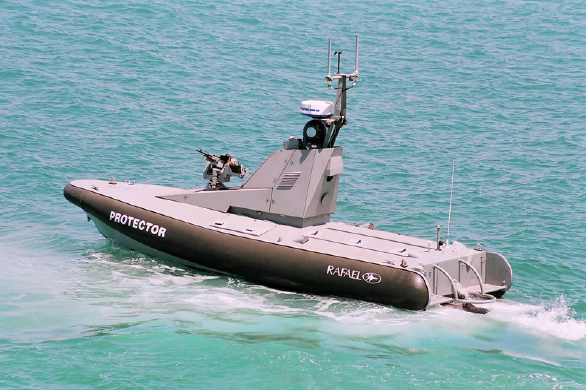
Figure 1: One example of an industrial-level USV is the remotely controlled Protector, developed by Rafael of Israel. This vehicle is a 9  long rigid-hulled in fl atable boat equipped with water jet propulsion that enables oper- ations of up to 20  (i.e., approximately 40 